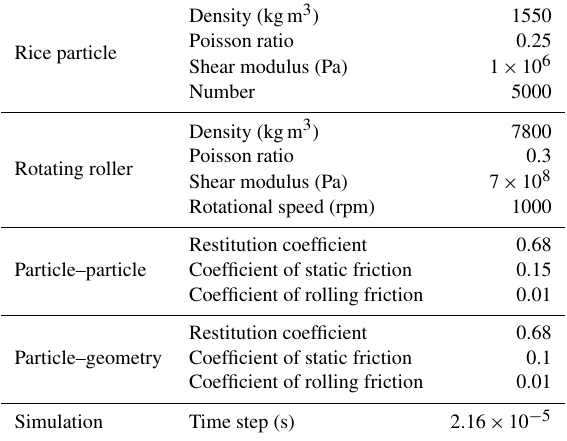
Table 2. Parameters in the DEM simulations (Cao et al., 2018).